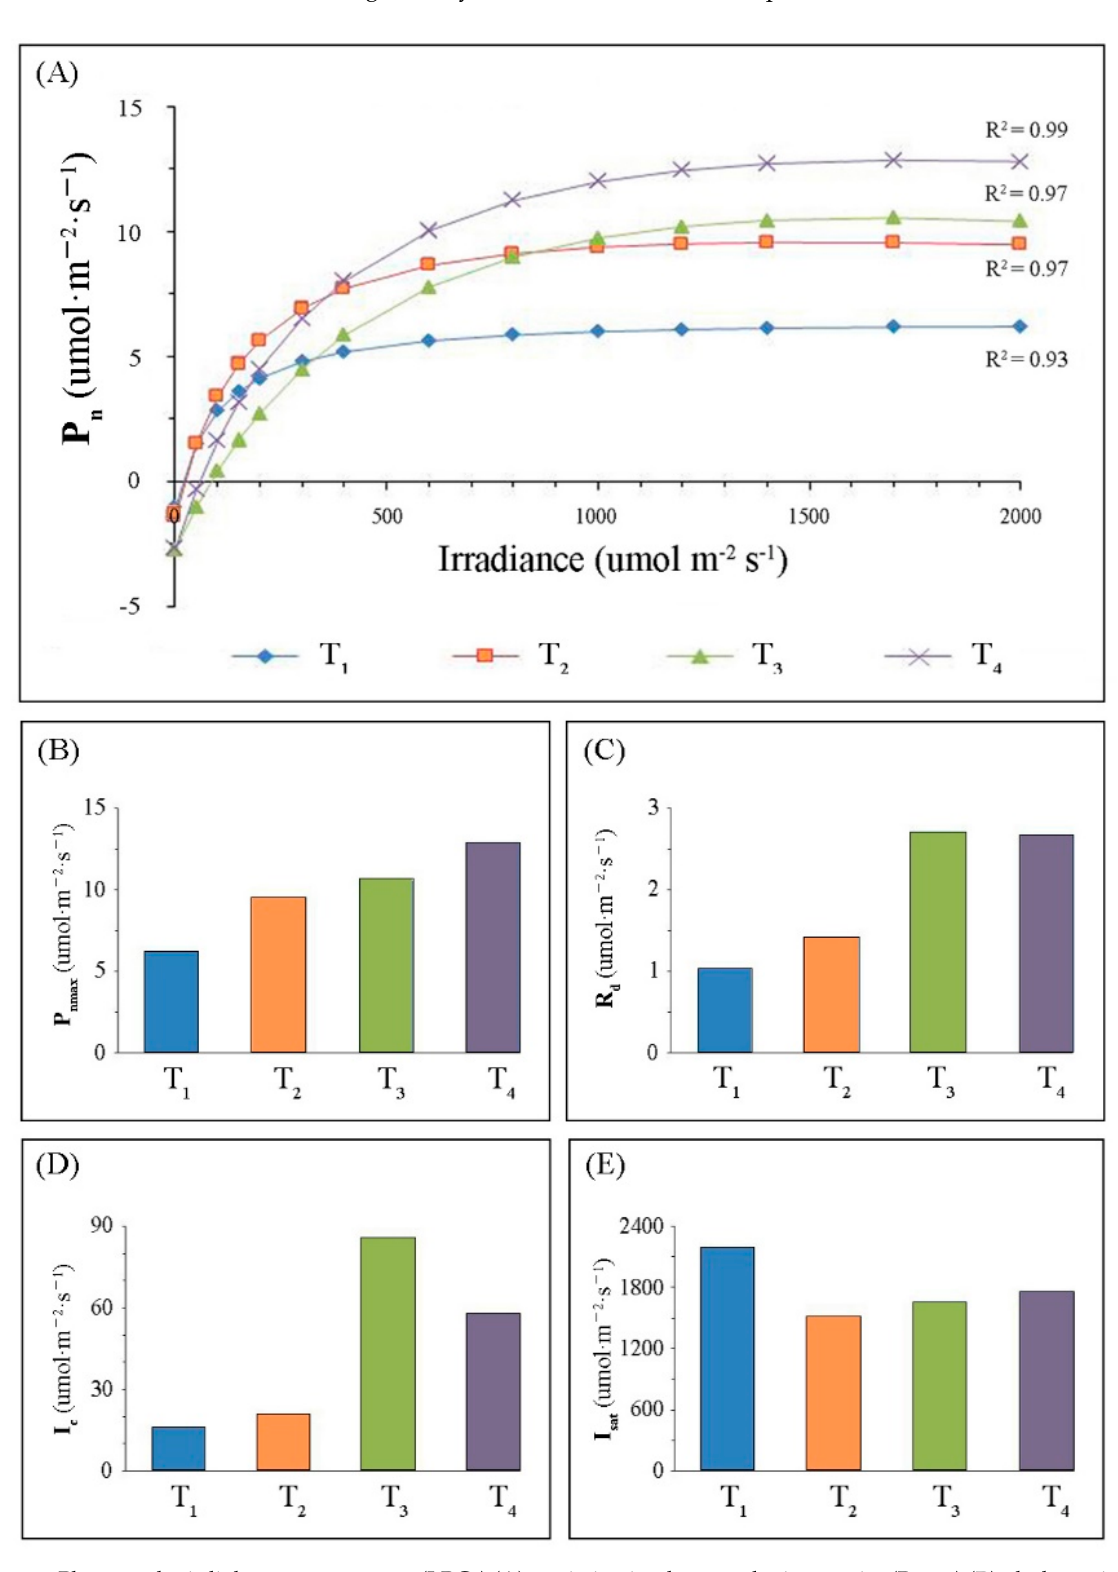
Figure 2. Photosynthetic light response curves (LRCs) ( A ), variation in photosynthetic capacity (P nmax ) ( B ), dark respiration rate (R d ) ( C ), light compensation point (I c ) ( D ), and light saturation point (I sat ) ( E ) over four different leaf-developmental stages (T 1 –T 4 ).